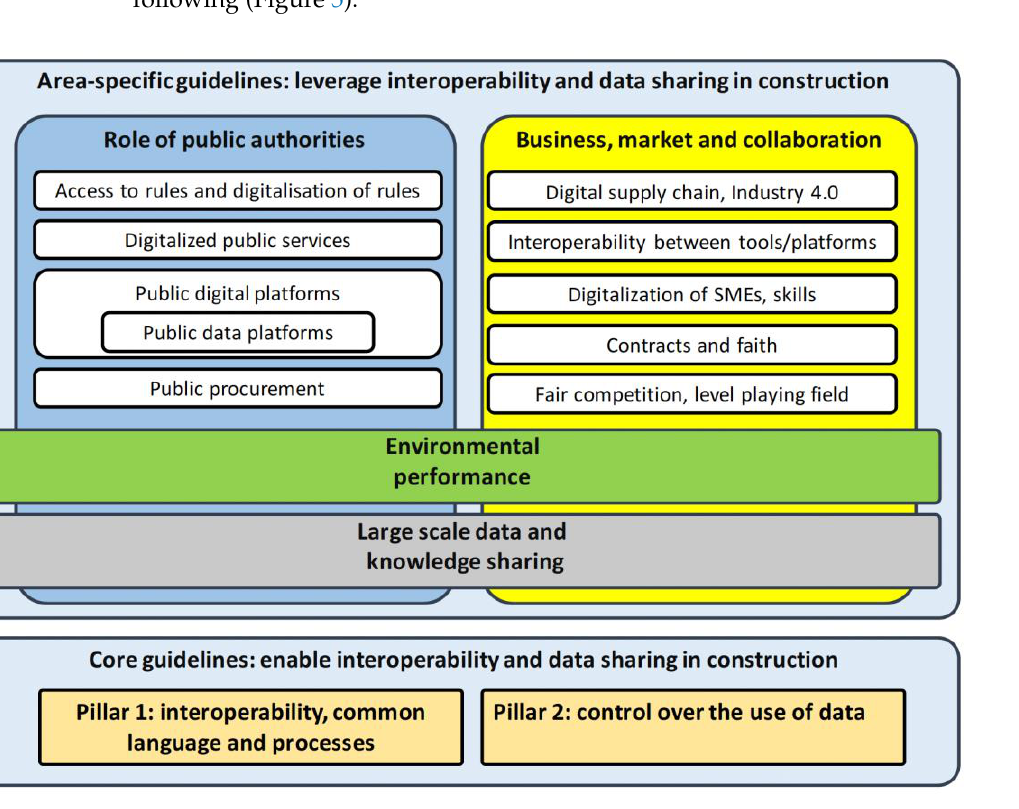
Figure 5. Reference Architecture Framework for construction digital platforms (reprinted with permission from [59]).